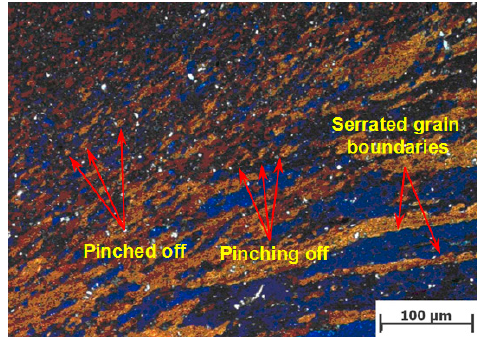
Figure 8. GDRX process observed in TMAZ of FSSW joint.